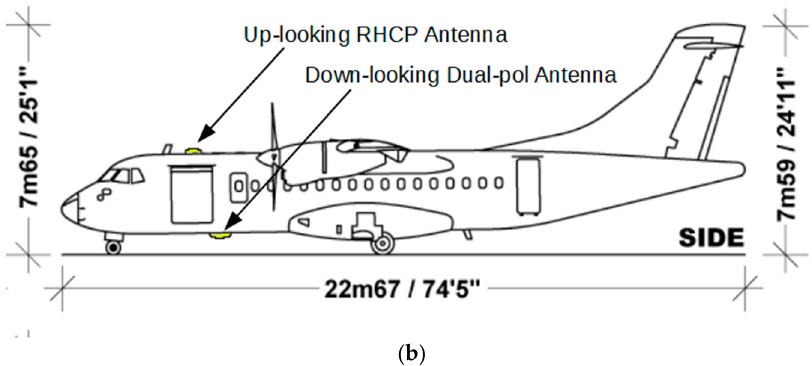
Figure 1. ( a ) The GLORI instrument; ( b ) The SAFIRE ATR 42 Aircraft.